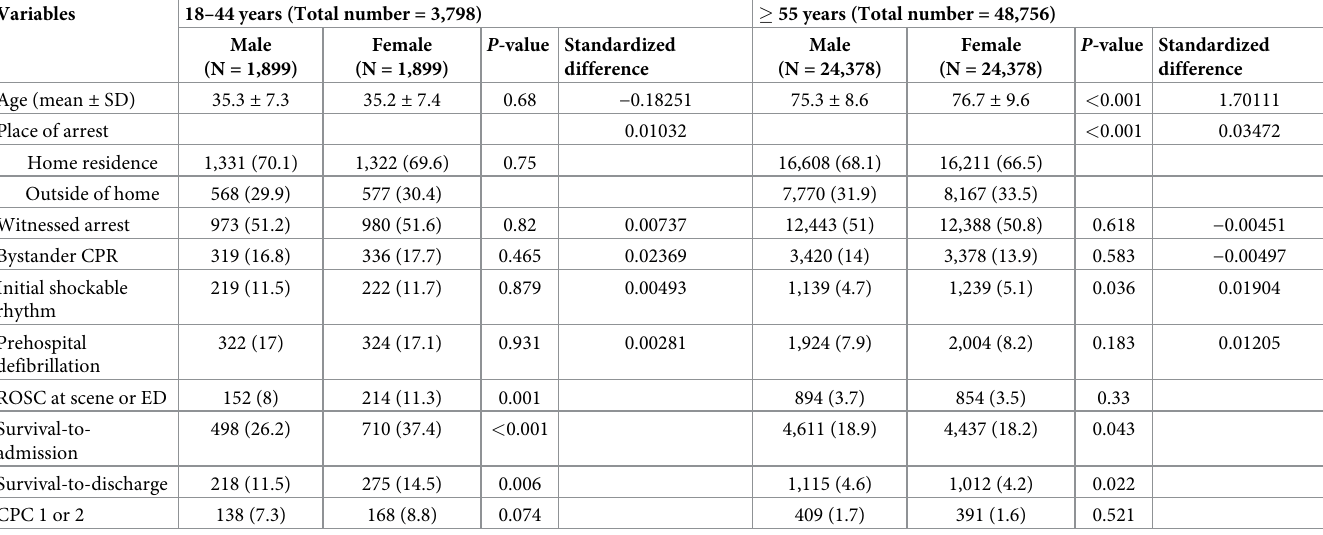
Table 4. Characteristics of patients with out-of-hospital arrest by age group and sex after propensity score matching.